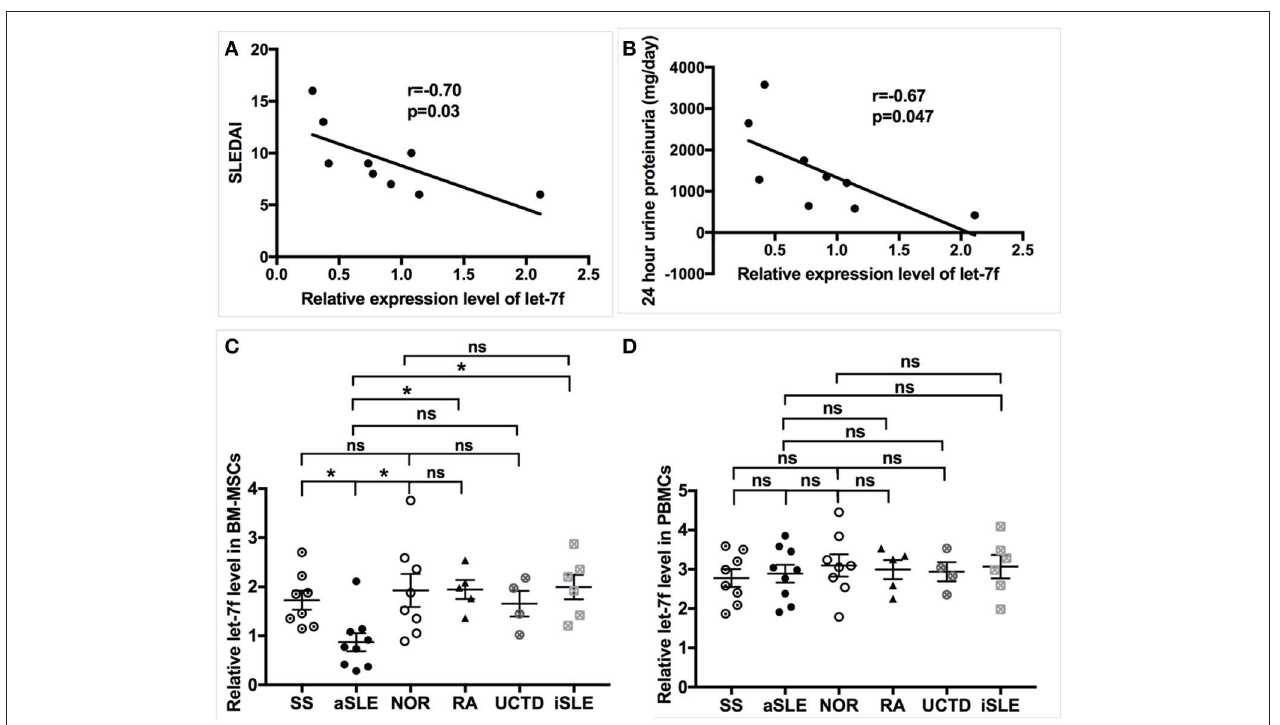
FIGURE 1 | Association of let-7f in SLE BM-MSCs with clinical manifestiations of SLE patients. (A,B) Association of let-7f expression in BM-MSCs with SLE disease activity index (SLEDAI, A ) score and 24h urine proteinuria (mg/day, B ). (C) Let-7f expression in BM-MSCs from patients with active SLE (aSLE, n = 9), inactive SLE (iSLE, n = 6), RA( n = 5), pSS( n = 8), UCTD ( n = 4), and NOR ( n = 10). (D) Let-7f expression in PBMCs from patients with aSLE ( n = 9), iSLE( n = 6), RA( n = 5), pSS( n = 8), UCTD ( n = 4), and NOR ( n = 10). All data are mean ± SEM. * P <